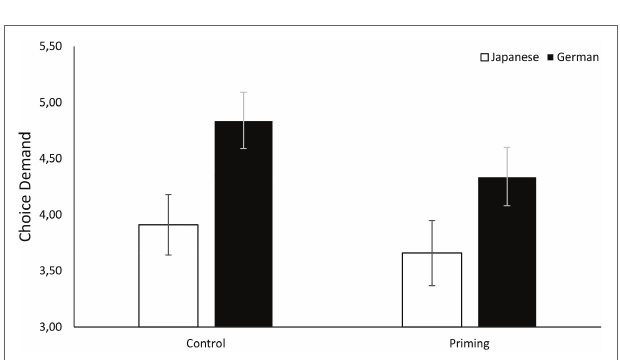
FIGURE 6 | Cultural and group differences in choice demand as a reaction to vicarious choice in Study 3. Error bars show 95% confidence